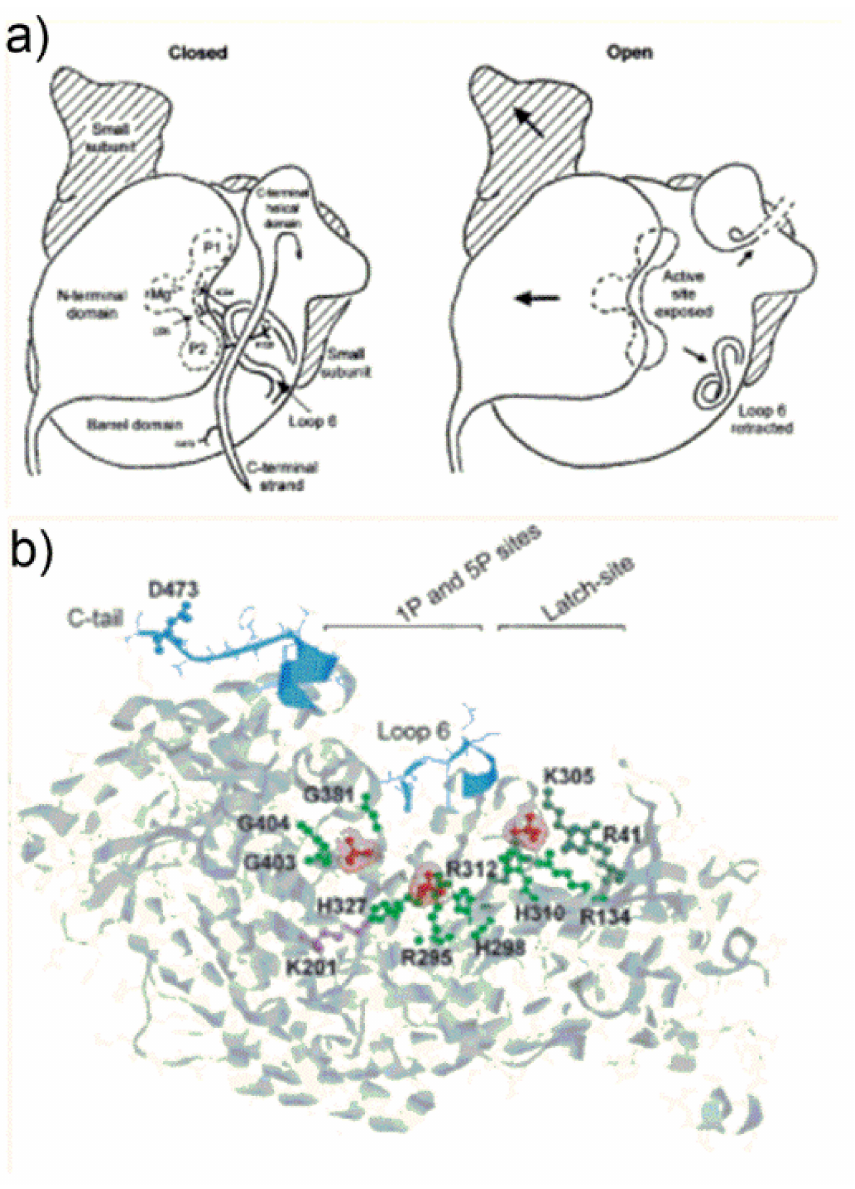
Figure 8. ( a ) Schematic illustration of the “open” to “closed” state transition of the catalytic site of Rubisco. The “open” to “closed” transition occurs through a sequence of three main conformational changes; ( b ) evidences the binding sites for 1P- and 5P-groups of RuBP (in red) in Rubisco from the cyanobacterium Synechocystis sp. The third phosphate group shown (in the latch-site) is assigned a particular role in the regulation of catalysis (Figure 8a from ref. [38], used by permission of Elsevier (copyright 2000); Figure 8b from ref. [39], adapted and used by permission of American Society of Microbiology (copyright ©